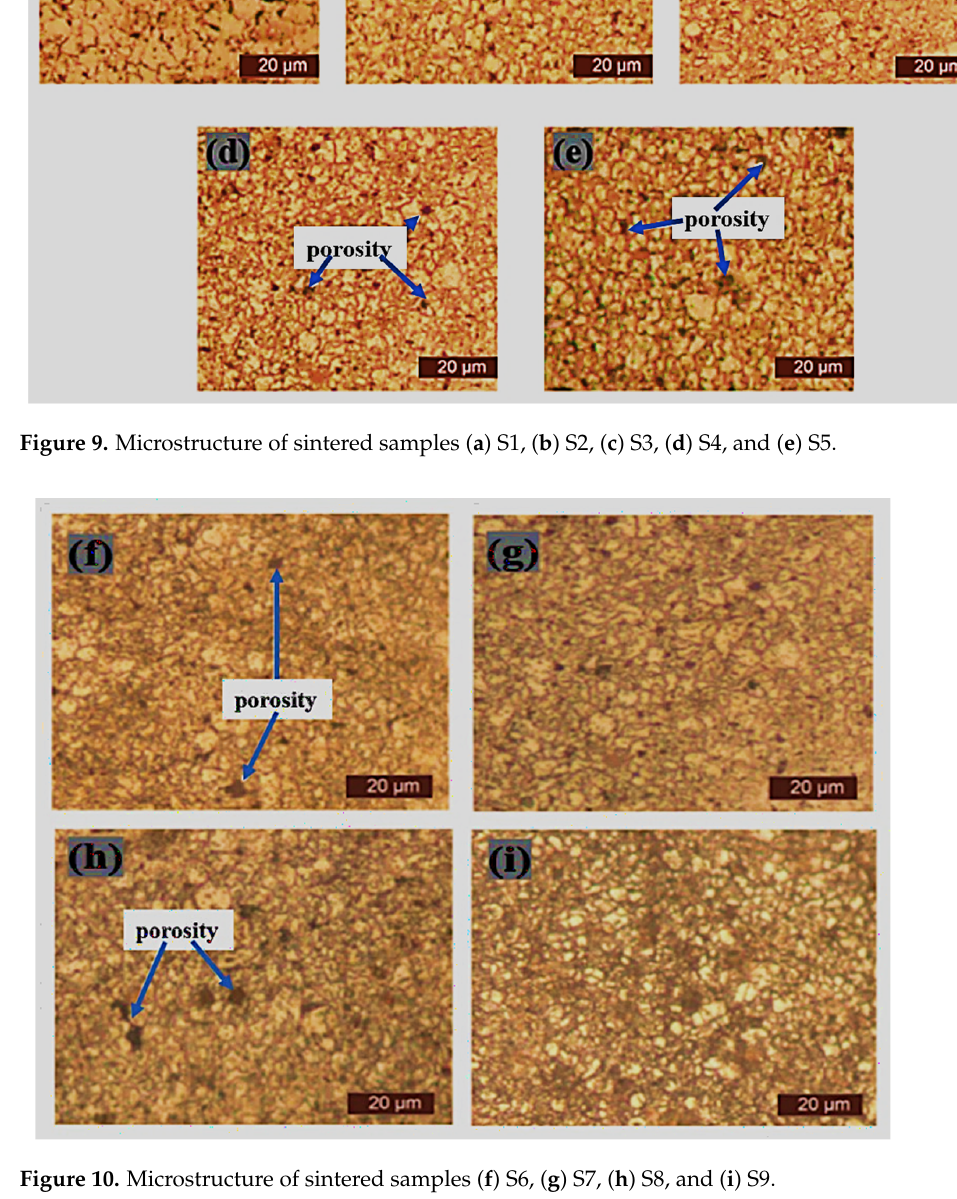
Figure 11. Microstructure of sintered samples ( j ) S10, ( k ) S11, and ( l ) S12. Figure 12. Microstructure of sintered samples ( m ) S13, ( n ) S14, and ( p ) S15. 3.4. Microhardness of Sintered Samples The microhardness of sintered samples is given in Table 4. Pure 316L stainless steel samples showed a microhardness of 235 HV. The microhardness of (B-Ti 316L SS) formulations increased the samples’ hardness compared to that of pure 316L stainless steel samples. From Table 4, it should be noted that as the titanium concentration increased, so did the microhardness. An enhancement of microhardness was noted for all the samples. The samples with 2 wt.% titanium addi- tions had a microhardness of 366 HV. The infusion of nitrogen into the matrix increased the microhardness of the (B-Nb 316L SS) formulations’ samples, indicating an increase in microhardness. The inclusion of